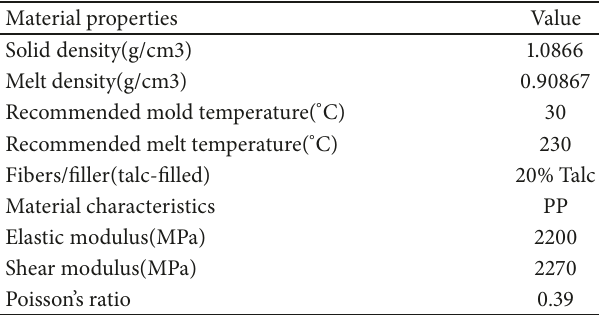
Table 1: Material properties of